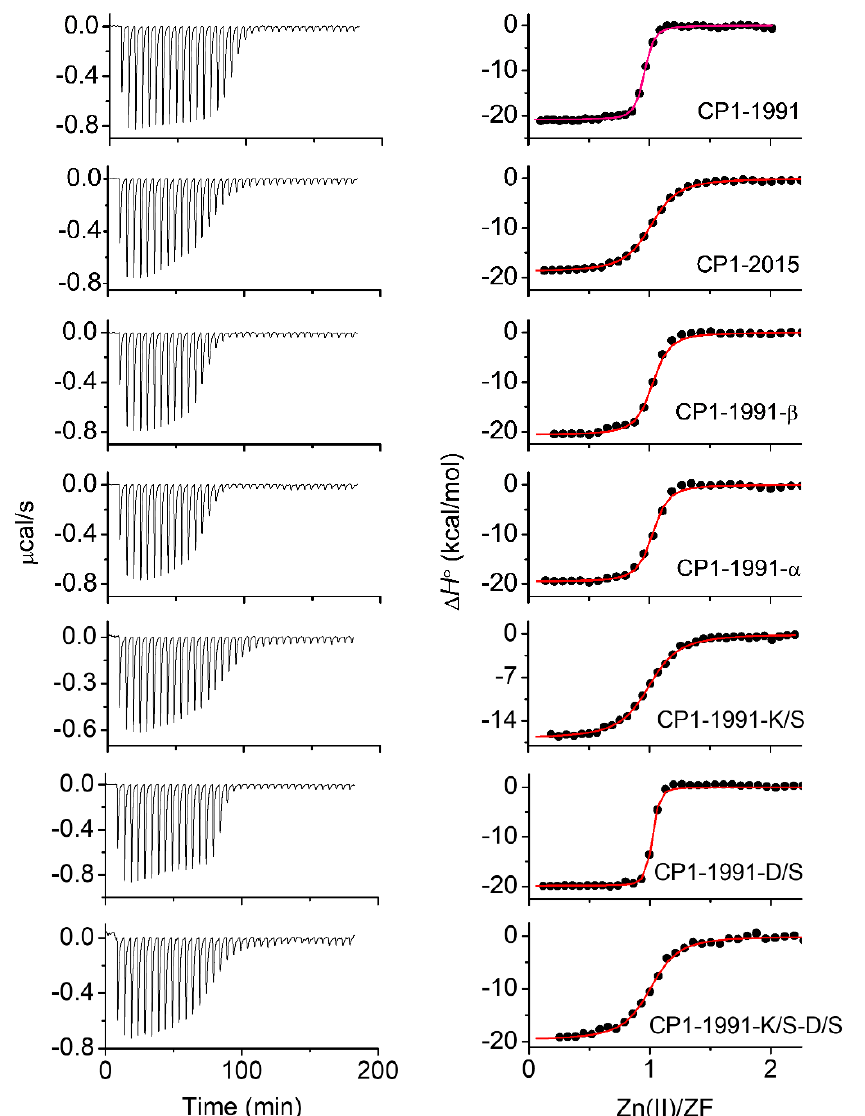
Figure 5. ITC binding isotherms ( left panel ) and best fits ( right panel ) for Zn(II) titrations into ex- amined ZFs with multiple mutations: CP1-1991 (n = 0.99), CP1-2015 (n = 0.99), CP1-1991- α (n = 0.82), CP1-1991- β (n = 0.99) and point mutations: CP1 -1991-K/S (n = 0.98), CP1-1991-D/S (n = 0.98), CP1-1991-K/S-D/S (n = 0.98) in 50 mM HEPES I = 0.1 M (from NaCl), pH 7.4 at 25 °C.